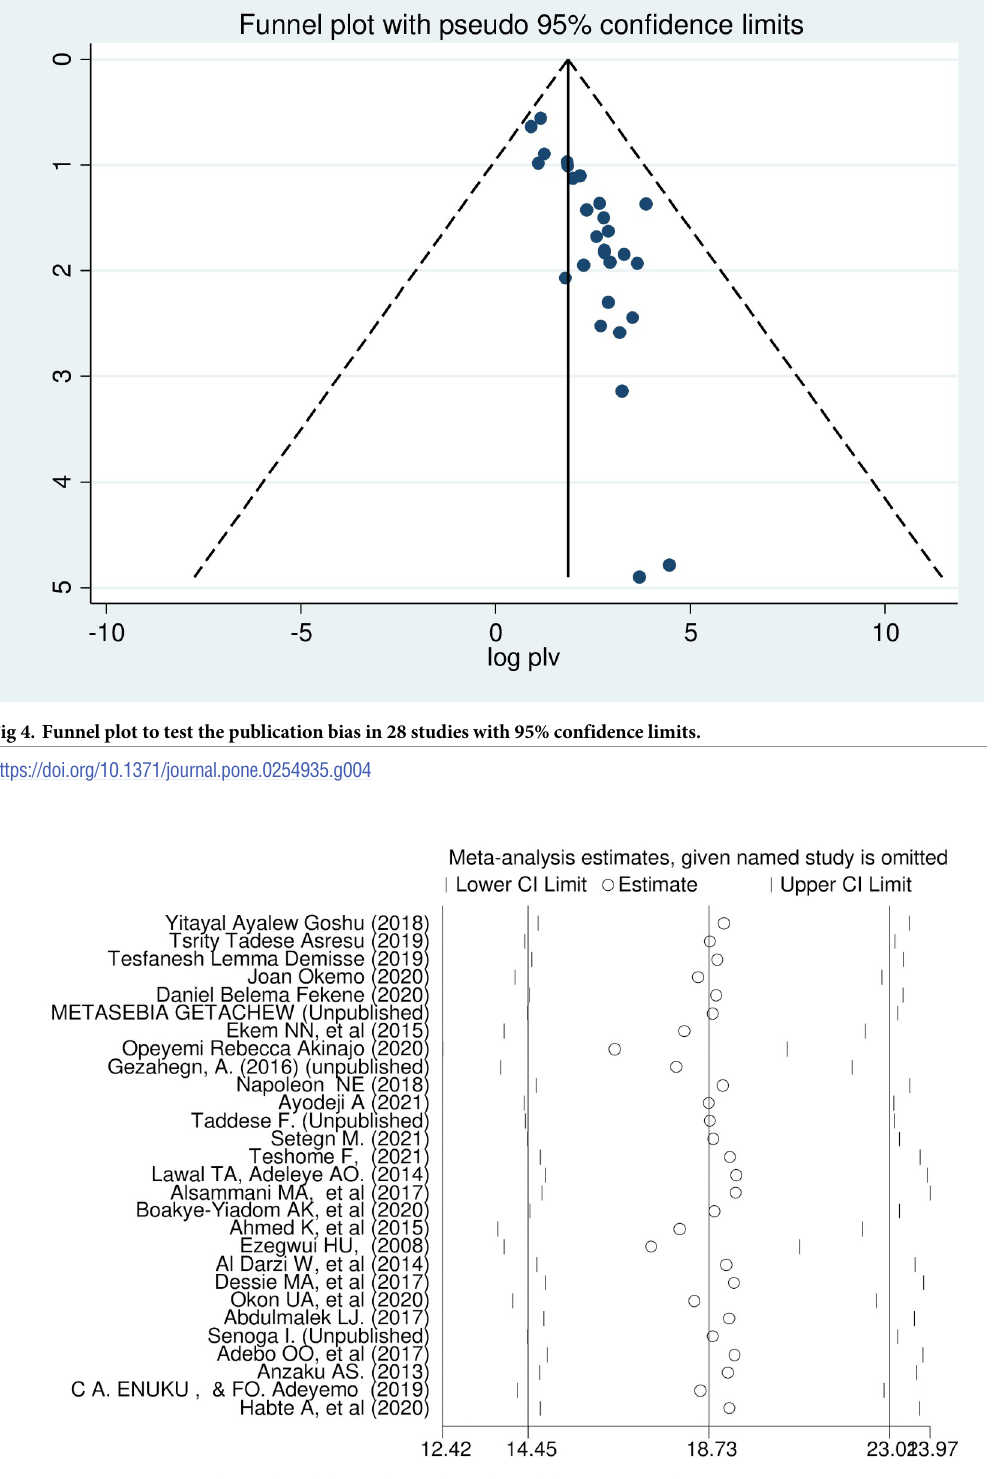
PLOS ONE | https://doi.org/10.1371/journal.pone.0254935 July 23,